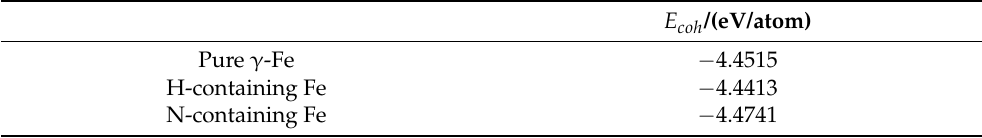
Table 1. Cohesive energy of all models without atomic oxygen adsorption.